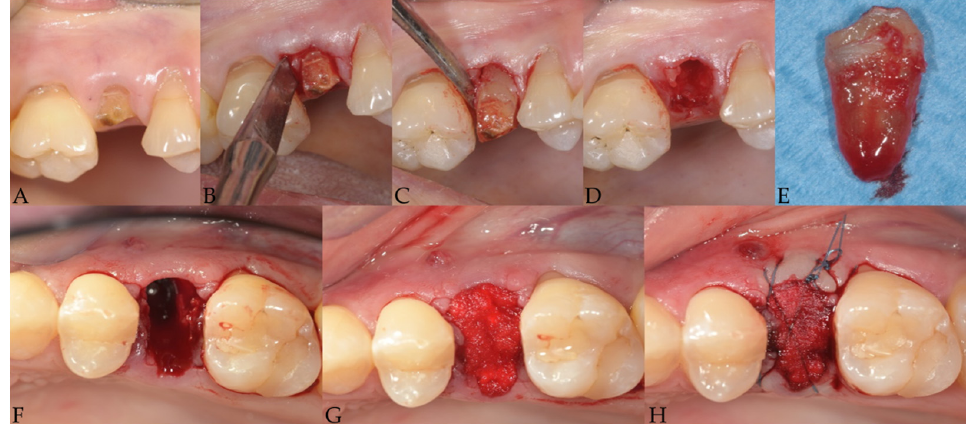
Figure 2. Clinical view of a less extraction technique. ( A ) preoperative; ( B , C ) electromagnetic tips for mesial and distal luxation; ( D ) extraction; ( E ) extracted tooth; ( F ) post extraction socket; ( G ) gelatin sponge; ( H ) sutures.